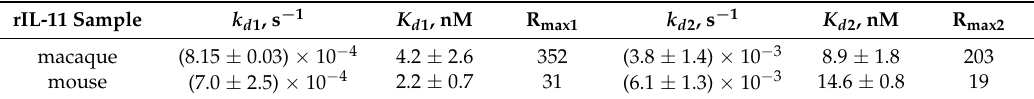
Table 1. Kinetic and equilibrium dissociation constants describing the SPR data (Figure 5) on interaction of macaque/mouse rIL-11 with sIL-11R α according to the heterogeneous ligand model (1). Standard deviations estimated from the global fit of three kinetic SPR curves measured at different analyte concentrations are indicated.